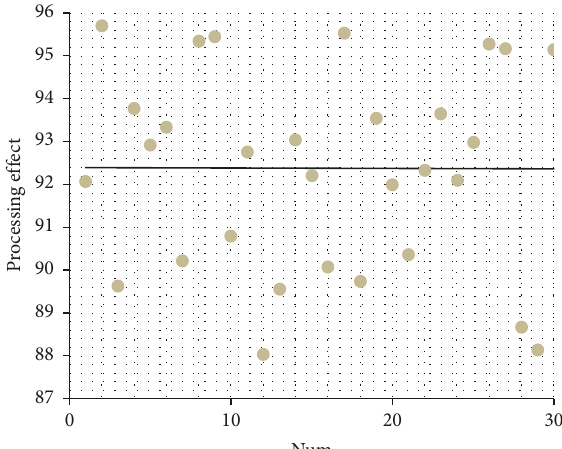
Figure 13: Statistical diagram of the evaluation of the effect of the CNC machining